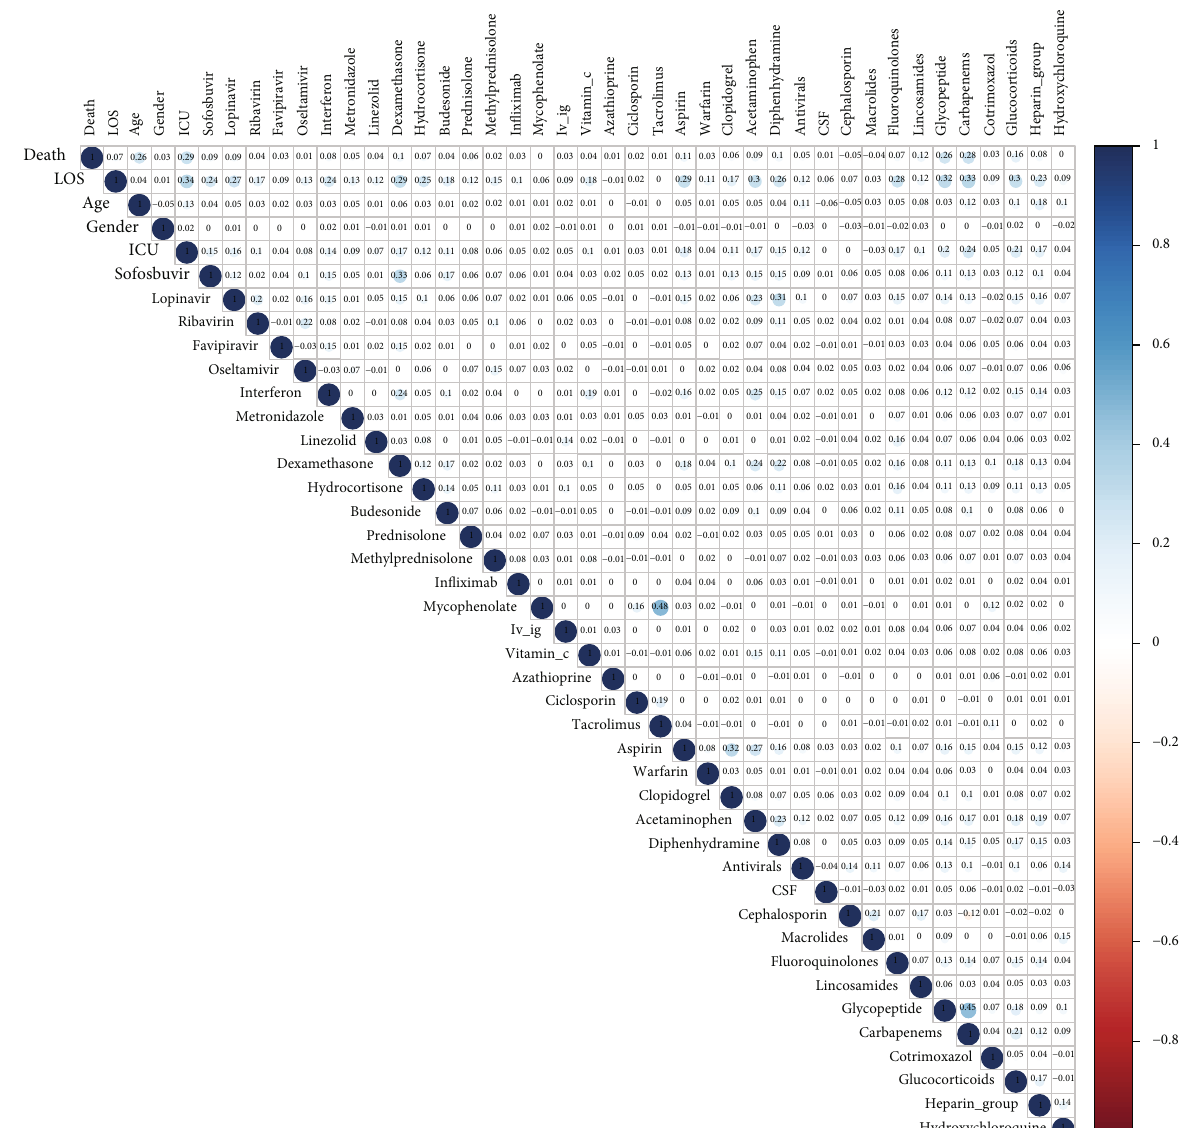
Figure 1: Correlation plot for association rule